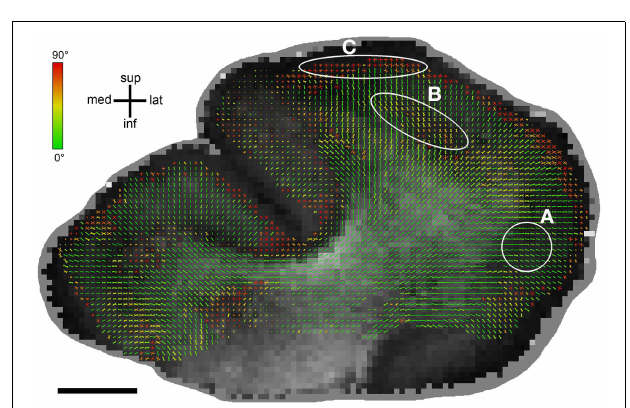
FIGURE 6 | Differences between MRI DT and Hist ST orientations displayed on an FA map. MRI DT and Hist ST orientations are plotted in a color range from green (for orientations that perfectly agree) to red (for orientations that differ by 90 ◦ ). Bar length reflects the projection length of the diffusion tensor in the sectioning plane. There is a generally good histology-DTI agreement for high FA values, especially in white matter. For lower FA, particularly when entering gray matter, there are three cases: (A) Good agreement in case of predominant radial orientations, (B) Moderate to weak agreement, (C) Perpendicular histology-DT orientedness. Here, voxels are located well within gray matter and run in bands parallel to the cortical surface. Scale bar: